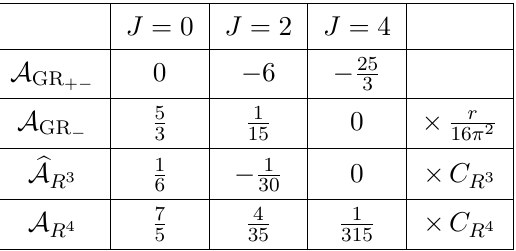
Table 2 . Values of the coefficients a J in the s -channel for the different 4-graviton amplitudes defined in the text. For the tree-level GR amplitude A GR regularized quantity defined in eq. (3.35) up to J = 4